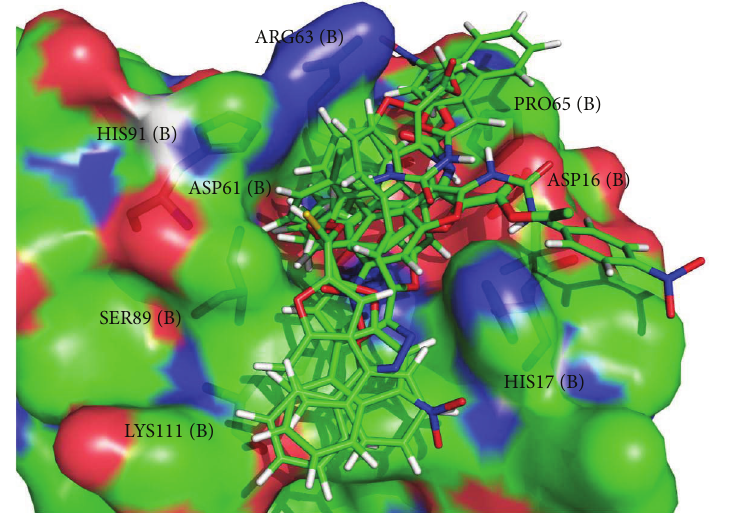
Figure 7: Interaction of all ligands at the active site of NarL.